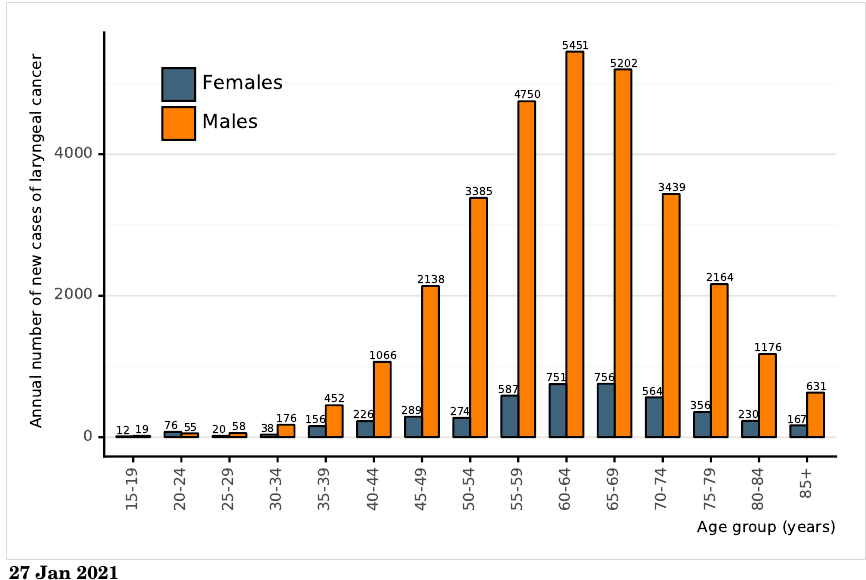
Figure 49: Annual number of new cases of laryngeal cancer in India (estimates for